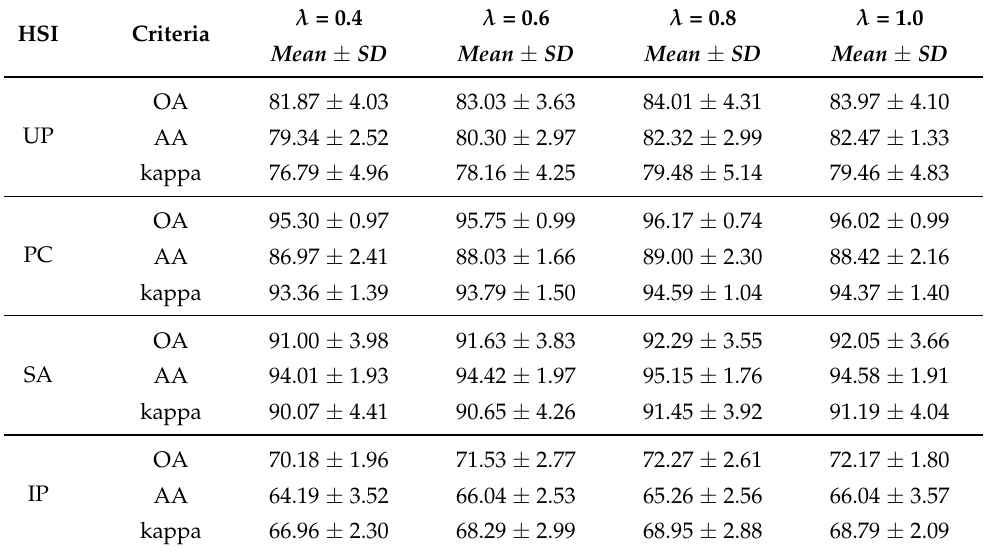
Table 5. The results of the proposed method when hyperparameter λ